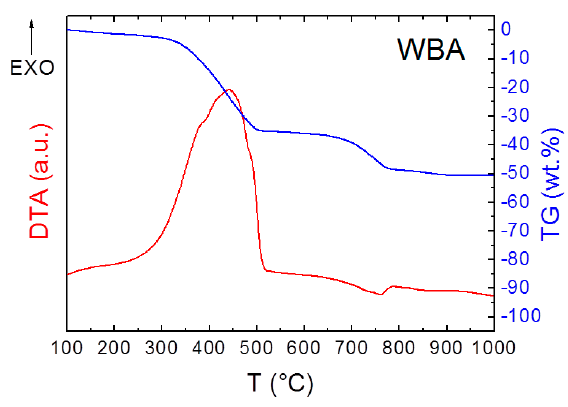
Figure 8. TG and DTA curves of WBA.